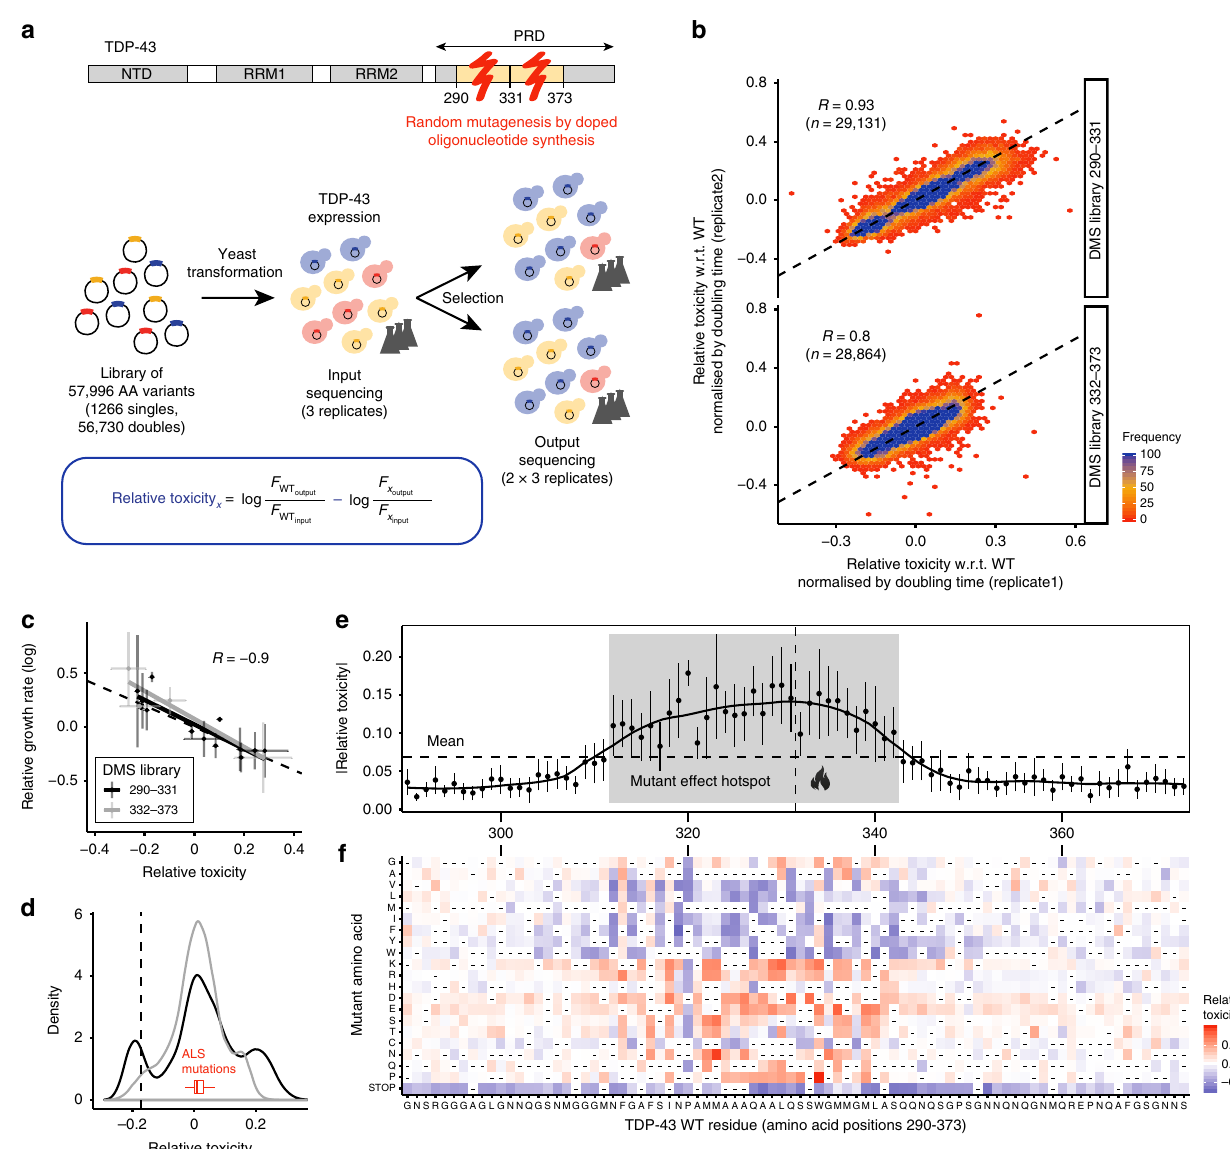
Fig. 1 Deep mutational scanning (DMS) of the prion-like domain (PRD) of TDP-43. a Domain structure of TDP-43 and DMS experimental protocol: For each library, three independent selection experiments were performed. In each experiment one input culture was split into two cultures for selection upon induction of TDP-43 expression (6 outputs total). Relative toxicity of variants was calculated from changes of output to input frequencies relative to WT. b Correlation of toxicity estimates between replicates 1 and 2 for single and double amino acid (AA) mutants shown separately for each library (290 – 332; 332 – 373). The Pearson correlation coef fi cients (R) are indicated. Toxicity correlations between all replicates are shown in Supplementary Fig. 1d, e. c Comparison of toxicity from pooled selections and individually measured growth rates for selected variants. Vertical and horizontal error bars indicate 95% con fi dence intervals of mean growth rates and toxicity estimates respectively. Linear fi ts of the data are shown separately for each library and Pearson correlation (R) after pooling data from both libraries is indicated. d Toxicity distribution of single and double mutants, shown separately for each library (colour key as in panel ( c )). WT variant has toxicity of zero, mean toxicity of variants with single STOP codon mutation is indicated by dashed vertical line. The red boxplot depicts the distribution of toxicity estimates for all human disease mutations (including sporadic and familial ALS mutations). Outliers are not depicted but are reported in Supplementary Fig. 2d, e. e Absolute toxicity of single mutants strati fi ed by position. Error bars indicate 95% con fi dence intervals of mean (per-position) toxicity estimates. A local polynomial regression (loess) over toxicity estimates of all single mutants is shown. The vertical dashed line indicates the boundary between the two DMS libraries. The horizontal dashed line indicates the mean absolute toxicity of all single mutants. The mutant effect “ hotspot ” (mean per-position |toxicity| > mean |toxicity|) is highlighted in grey. f Heatmap showing single mutant toxicity estimates. The vertical axis indicates the identity of the substituted (mutant) AA. Heatmap cells of variants not present in the library are denoted by “ - charge and aromaticity do not predict toxicity (Fig. 2d, e, Sup- was unexpected given previous work that reported an increased plementary Fig. 4a) with aggregation potential accounting for an number of intracellular aggregates for a set of TDP-43 variants additional 4% of variance in the hotspot (Fig. 2f, g). toxic to yeast 54 and the widely-held view that aggregation is harmful to cells 42,52,56 . We therefore further investigated the effects That increased hydrophobicity and aggregation potential are of mutants that alter the hydrophobicity and toxicity of TDP-43. strongly associated with reduced toxicity across >50,000 genotypes